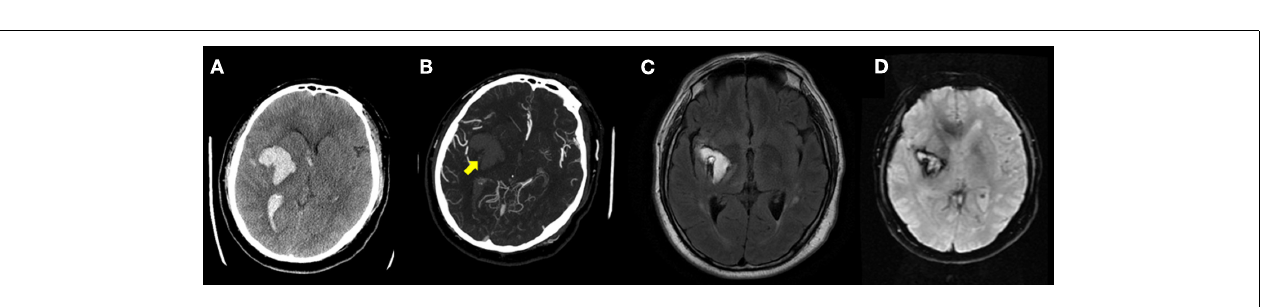
fluid attenuated inversion recovery (FLAIR) MRI 6 weeks post ictus. (D) No microhemorrhage is seen on gradient echo MRI sequence consistent with a CAA negative status according to the Boston